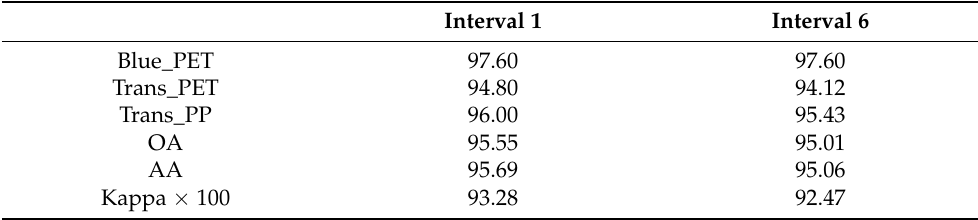
Table 2. RHFF-SOLOv1 classification results (%) based on different spectral feature